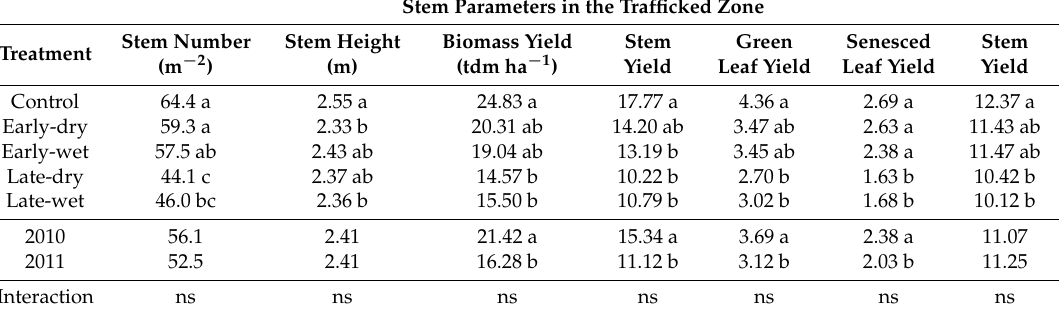
Table 5. Effect of treatment and year on growth and yield parameters measured in November (Trafficked Zone) and January